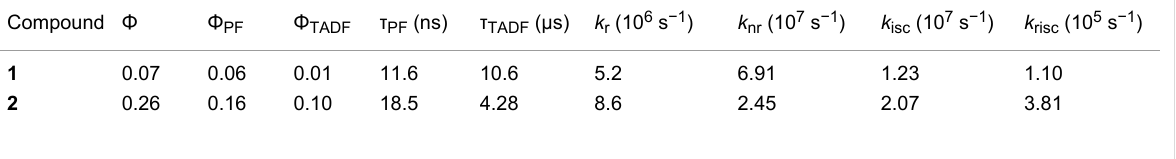
Table 4: Photophysical properties of the 1 and 2 doped in CBP films (8 wt %) at room